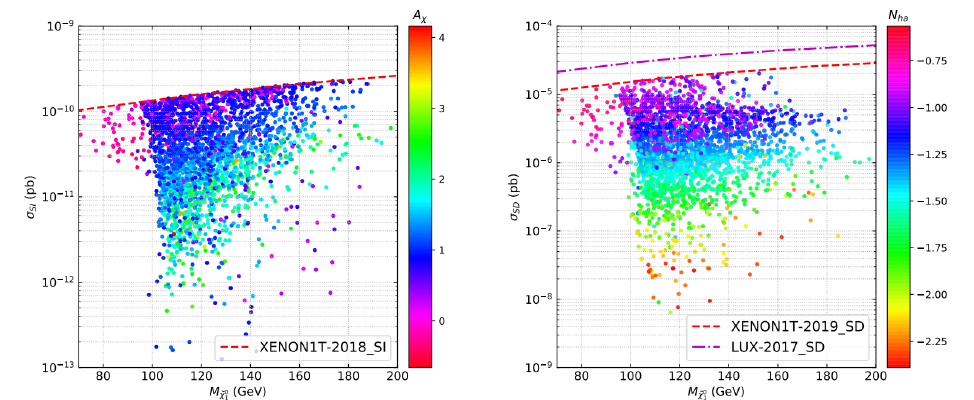
Figure 5 . The samples within the DM direct detection limits in figure 3. The colorbar represents A X ( N ha ) on the left (right) plot. We use the common logarithm of A X and N ha to reduce the impact of extreme values on the color